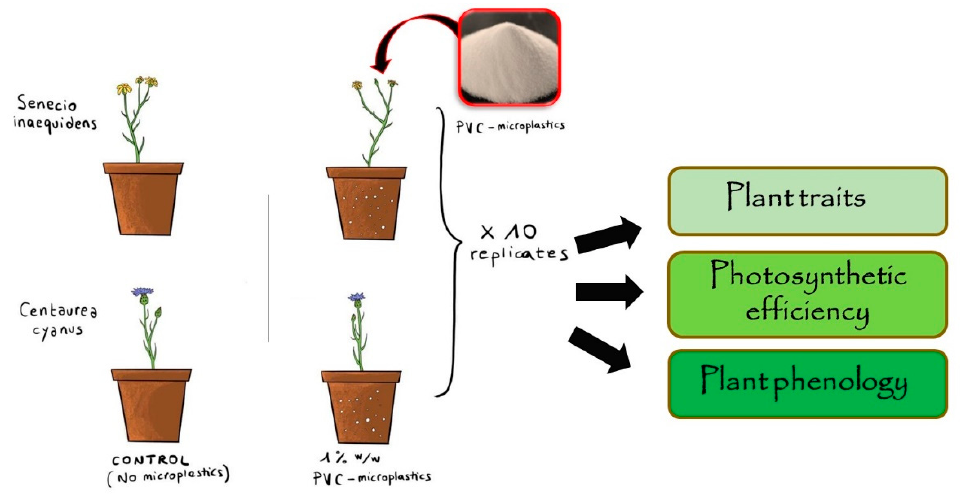
Figure 1. Experimental design: application of soil microplastics (PVC) to C. cyanus and S. inaequidens and measurements of plant traits, photosynthetic efficiency and plant phenology.